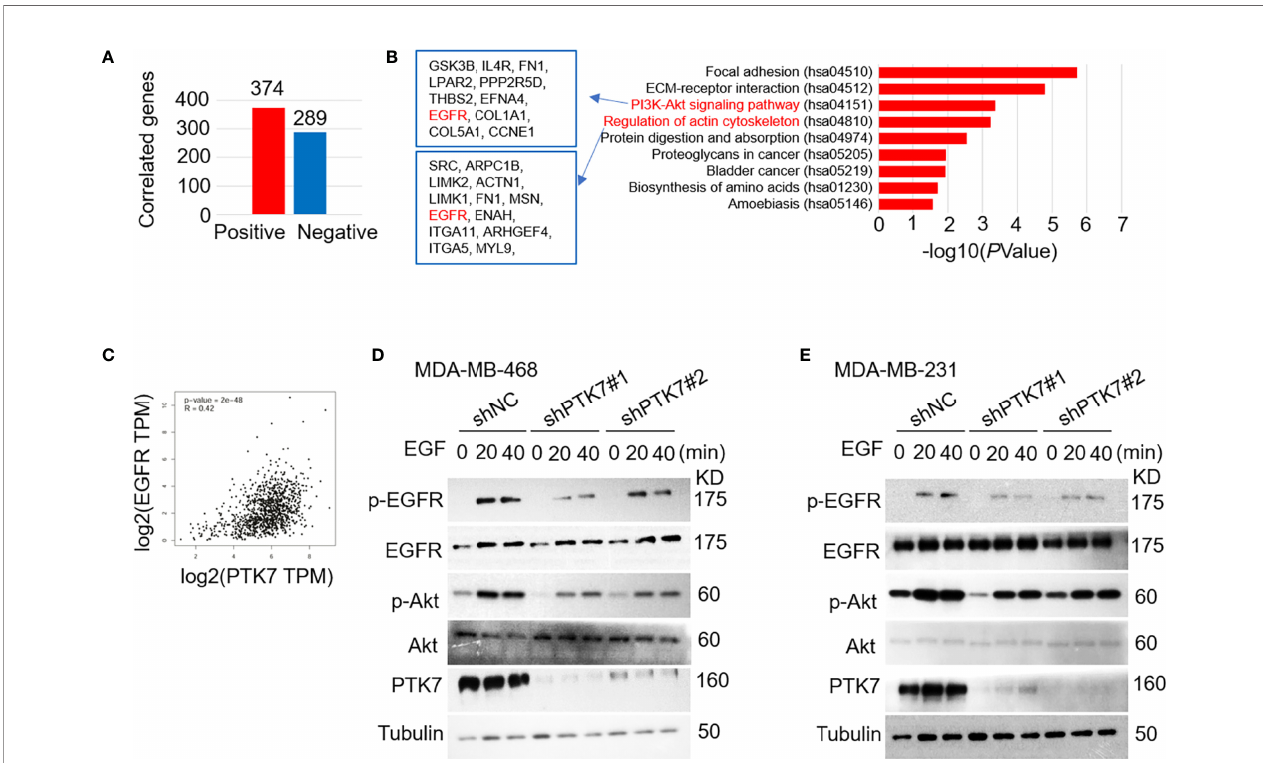
FIGURE 4 | PTK7 regulates EGFR-PI3K-Akt pathway in breast cancer. (A) PTK7 co-expression analysis in invasive breast carcinoma using breast cancer datasets including 1,904 patients with Agilent microarray data (http://www.cbioportal.org/) and 374 PTK7 positively- (Spearman ’ s correlation > 0.3, P < 0.01) and 289 PTK7 negative- (Spearman ’ s correlation < -0.3, P < 0.01) correlated genes were selected and used as candidate genes in the following analysis. (B) PTK7 positively- correlated genes were analyzed using Kyoto Encyclopedia of Genes and Genomes (KEGG) by DAVID: Functional Annotation Tools (https://david.ncifcrf.gov/tools. jsp). PTK7 positively correlated genes enriched in PI3K-Akt signaling (hsa04151) and Regulation of actin cytoskeleton (hsa04810) pathways are listed in the frames, respectively. (C) PTK7 and EGFR pair-wise gene correlation in breast invasive carcinoma were analyzed using GEPIA Correlation Analysis tools (http://gepia.cancer- pku.cn/detail.php?clicktag=correlation). (D, E) MDA-MB-468 (D) and MDA-MB-231 (E) cells were transduced with a non-targeting control shRNA (shNC) or two different PTK7-speci fi c shRNAs (shPTK71 and shPTK7#2). Cells were stimulated with EGF (500 ng/ml) for 0, 20 or 40 minutes and phospho-EGFR and phosphor- Akt levels were evaluated using immunoblotting